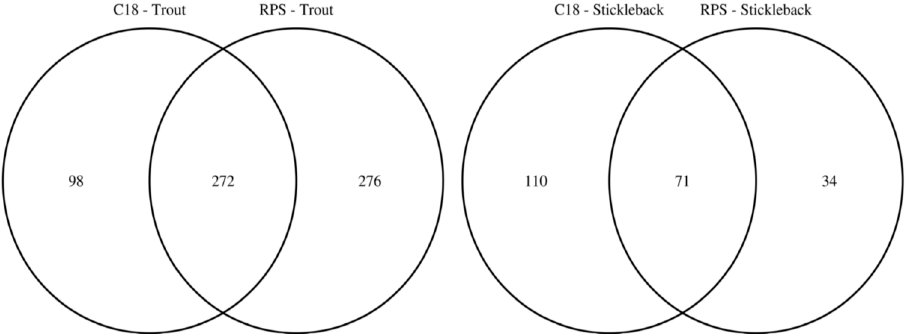
Figure 2. Venn diagrams highlighting the complementarity of C18 and SDB-RPS Empore™ disks in a Chemcatcher ® passive sampler, by showing the numbers of putatively annotated metabolites captured from the water by each type of disk for rainbow trout and three-spined stickleback. Relatively few metabolites are captured by both receiving phases.